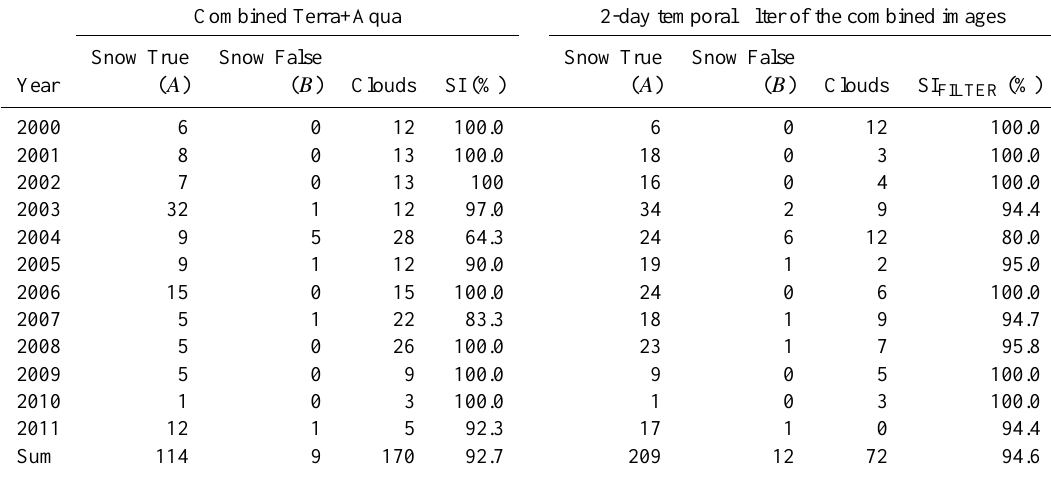
Table 4. Snow mapping accuracy (SI) at forest sites in the period 2000–2011. The A , B and Clouds categories represent the number of station days and are defined as in Table